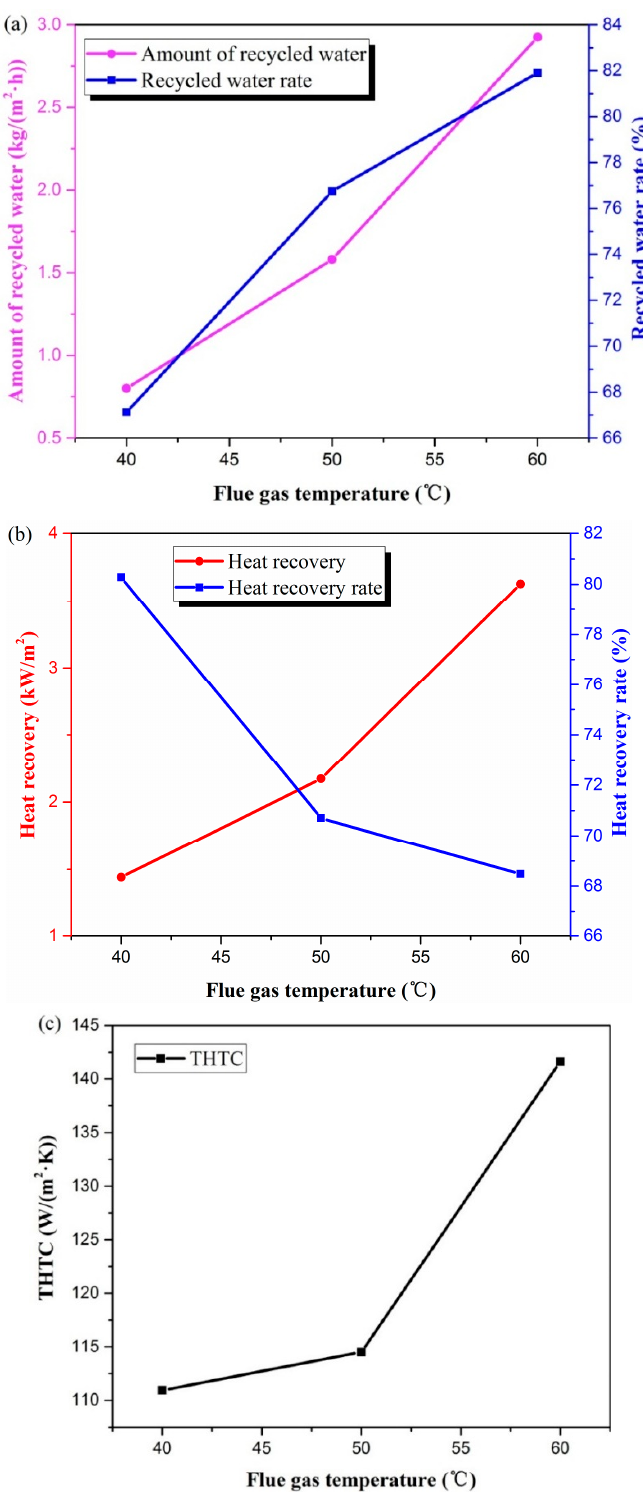
Figure 4. Variables changes with flue gas temperature in terms of ( a ) water, ( b ) heat, and ( c ) THTC. (Experimental conditions: flue gas flow rate 1.875 × 10 − 4 kg/s, water coolant flux 1.664 × 10 − 2 kg/s, water coolant temperature 20 °C).